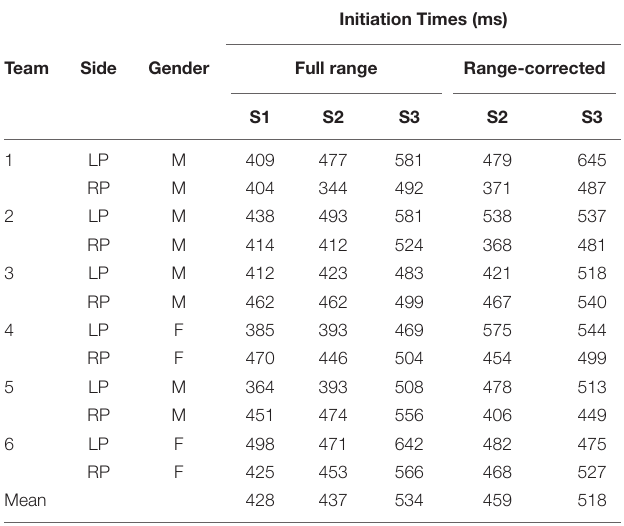
TABLE 3 | Mean initiation times of individual participants in Sessions 1 (S1), 2 (S2), and 3 (S3).